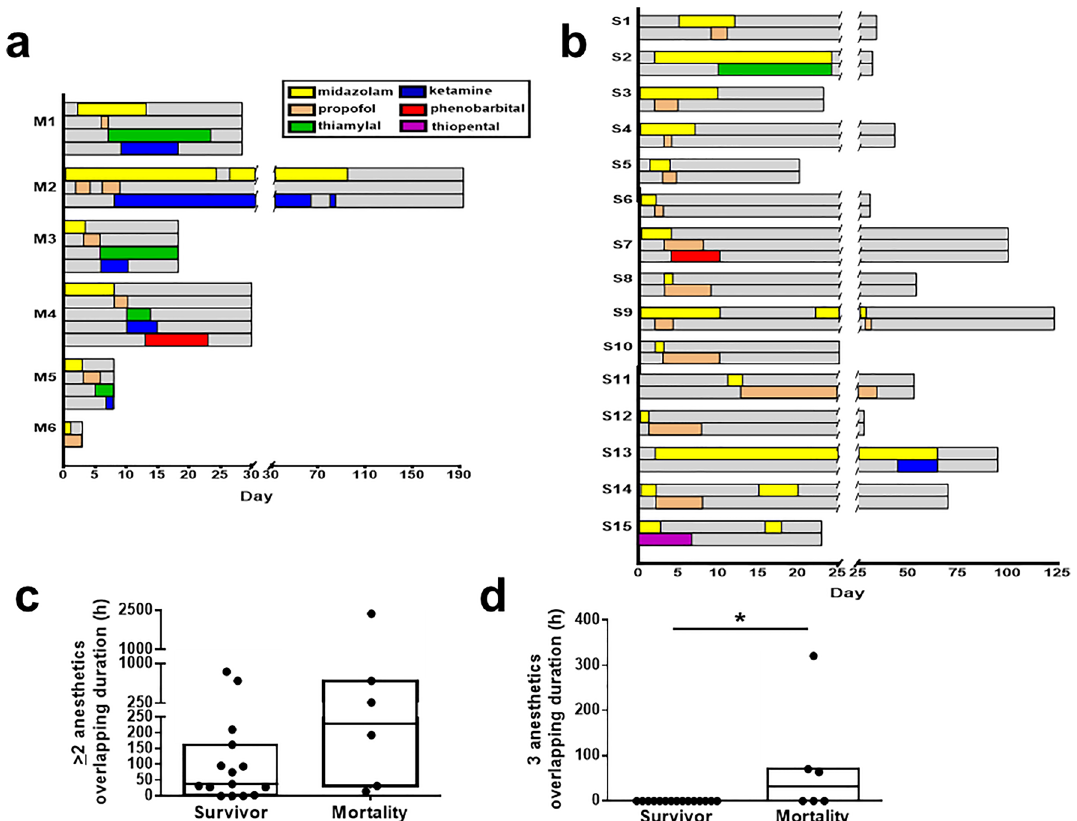
Figure 2. Time courses of anesthetics used in patients with SRSE. ( a ) Time courses of anesthetics used in patients of the mortality group following their hospital admission. ( b ) Time courses of anesthetics used in surviving patients with SRSE. ( c ) Overlapping durations of the combined use of two or more anesthetics comparing survival and mortality groups. ( d ) Overlapping durations of the combined use of three anesthetics comparing survival and mortality groups. Gray bars indicate the total duration of hospital stay for each patient. Anesthetics are labeled in different colors and presented chronologically for the hospital stay. SRSE super- refractory status